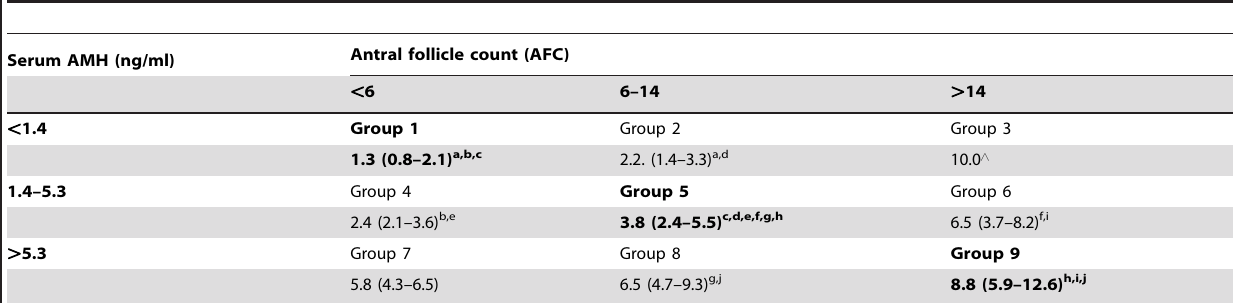
Table 4. Ovarian sensitivity index in different subject groups classified according to the quartile of serum AMH and AFC.